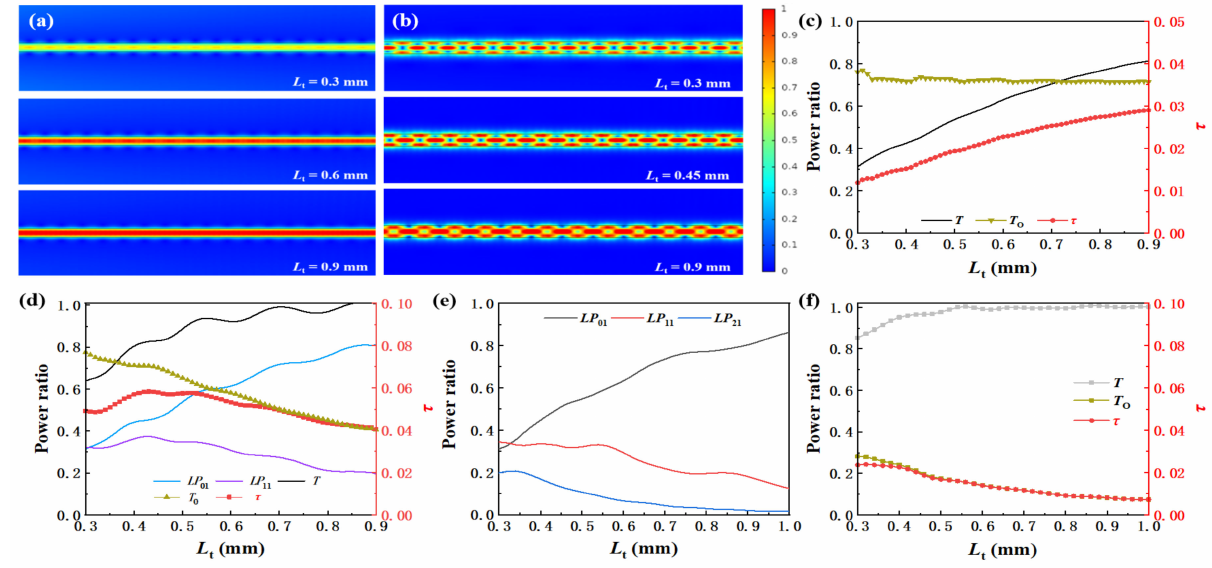
Figure 5. Calculated electric field in the waist as ( a ) R w = 1.45 µ m and ( b ) 2 µ m; calculated modes proportion, light transmittance, evanescent power ratio, evanescent efficiency with different L t as R w fixed to ( c ) 1.45 µ m and ( d ) 2 µ m; calculated ( e ) modes proportion; ( f ) light transmittance, evanescent power ratio, evanescent efficiency in the waist as R w is fixed at 4 µ